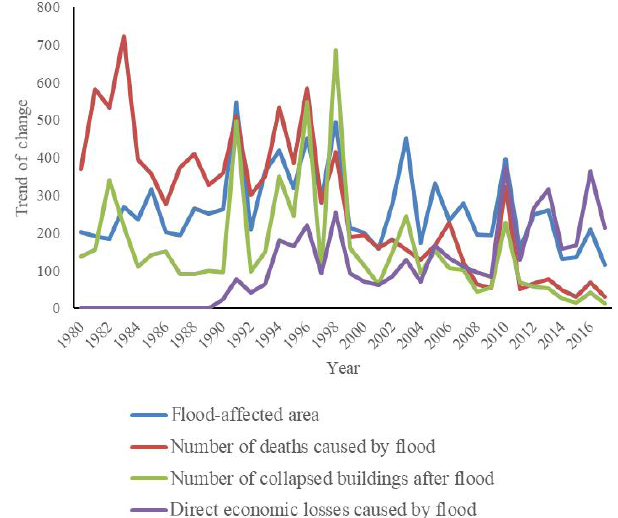
Figure 5. Trend of change (MWR, 2007–2016).